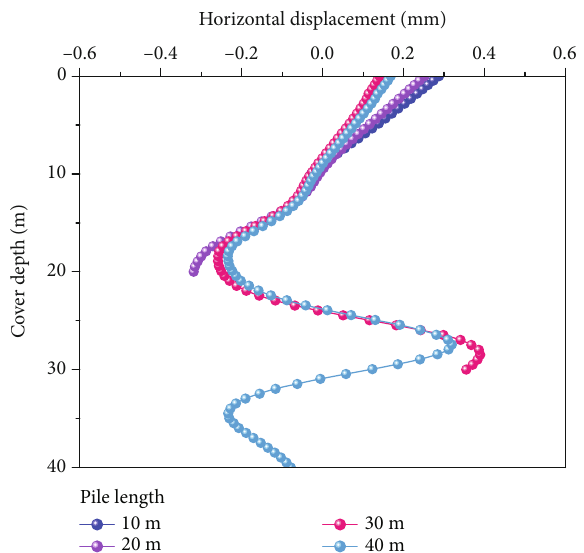
Figure 21: Variation of the horizontal pile displacement with the cover depth for di ff erent pile lengths.